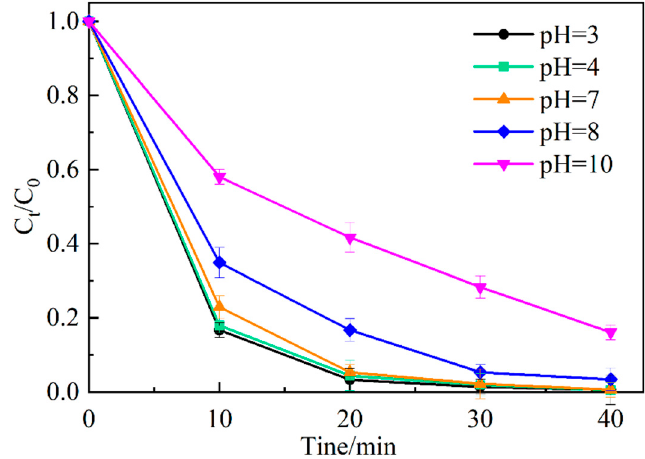
Figure 10. Effect of initial pH value on the degradation of